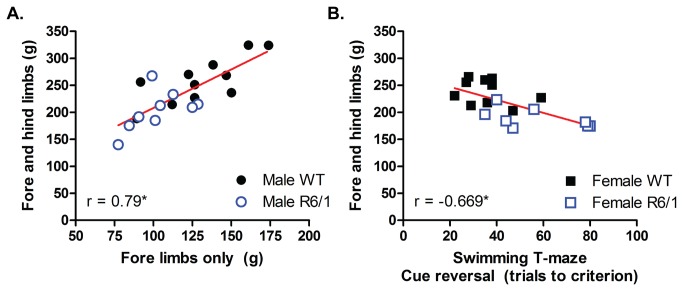
Concomitant deficits in behavioral tasks result in a robust correlation of those two measures.(A) At 18 weeks of age R6/1 mice have both lower forelimb, and fore- and hind limb grip strength capacity to a similar degree, separating the data from those of WT resulting in a significant, positive correlation (r=0.79, p<0.005). (B) Between 15-19 weeks of age R6/1 mice have lower fore- and hind limb grip strength, as well as impaired cue reversal learning in a swimming T-maze to a similar degree, forming a strong overall negative correlation (r=-0.669, p<0.005).